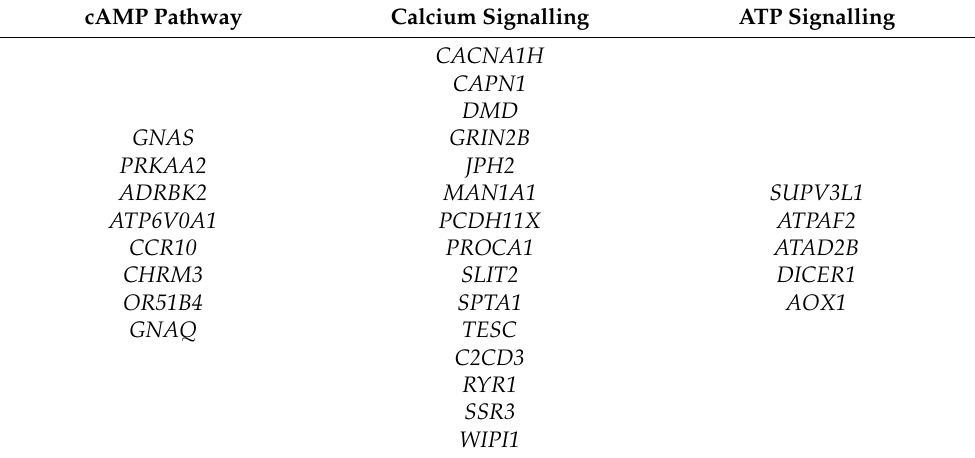
Table 2. Somatic variants associated with somatotroph PitNETs and with the cyclic adenosine monophosphatase (cAMP) pathway, calcium signalling, and adenosine triphosphate (ATP) signalling